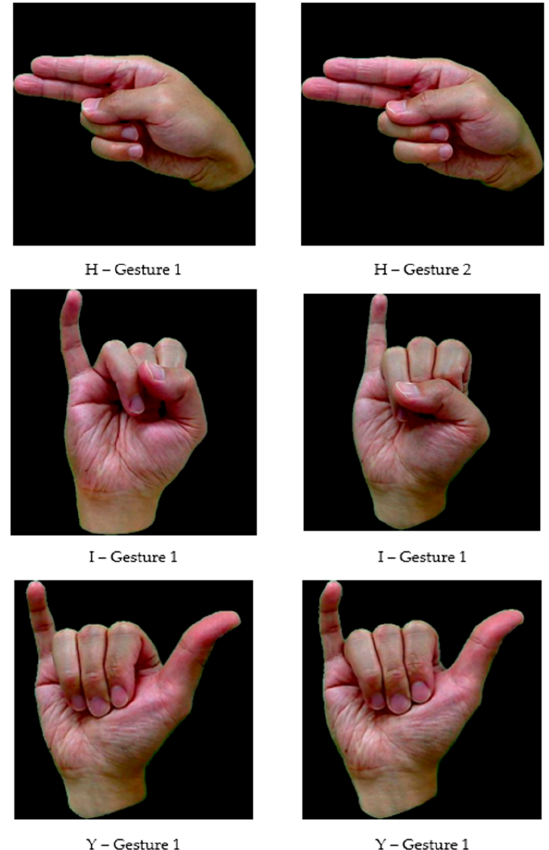
Figure 11. Hand gesture dataset for experiment 2.